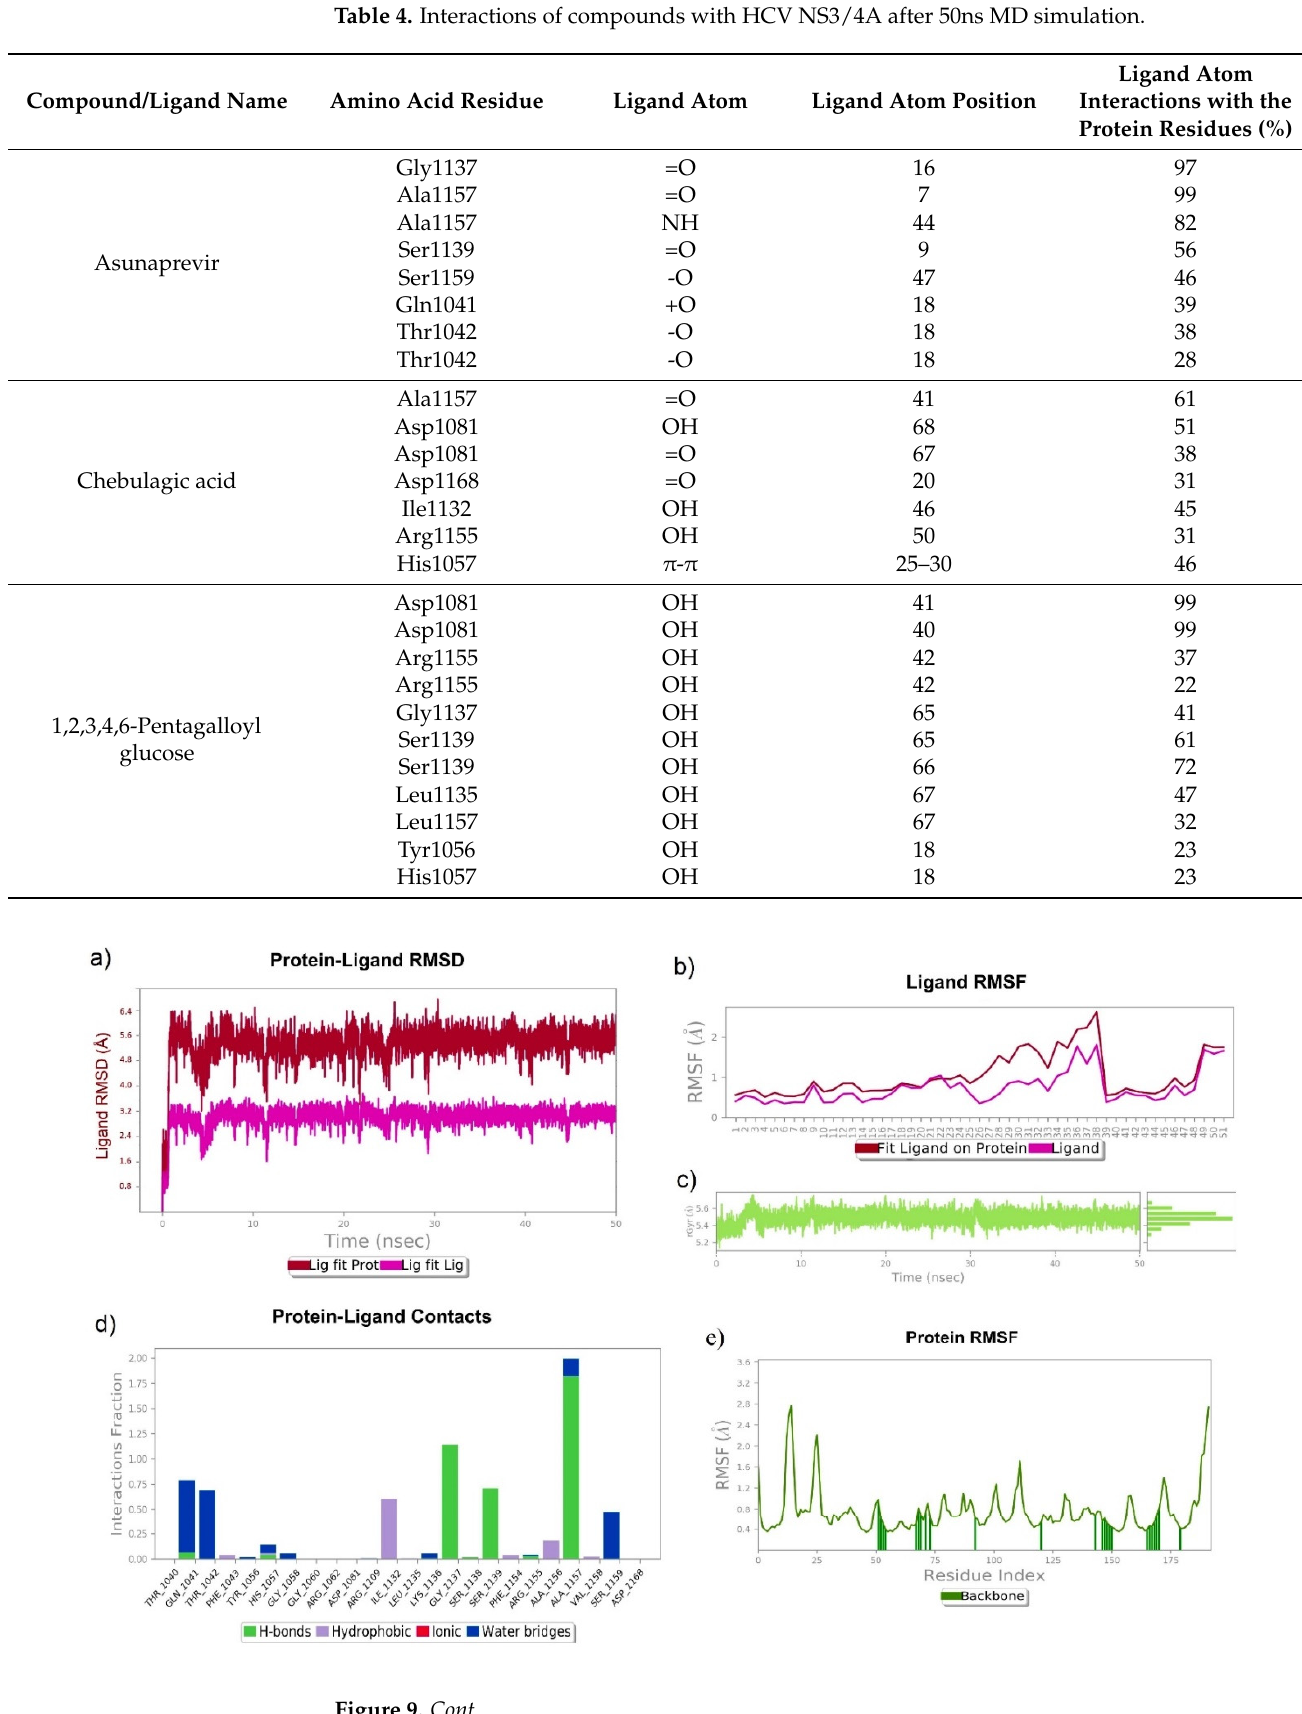
Figure 9. MD trajectories of Asunaprevir in complex with HCV NS3/4A for a 50 ns simulation: ( a ) RMSD, ( b ) RMSF, ( c ) rGyr, and ( d – f ) residue-wise ligand–protein contacts.